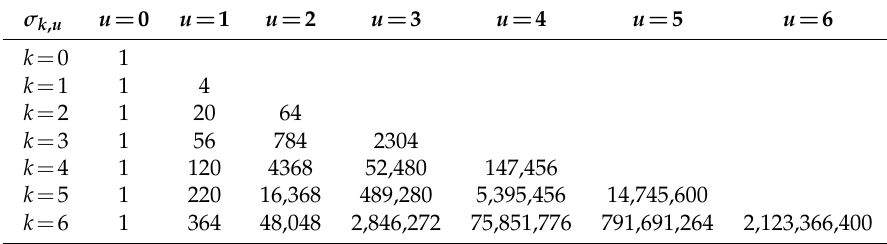
Table 1. Values of σ k , u